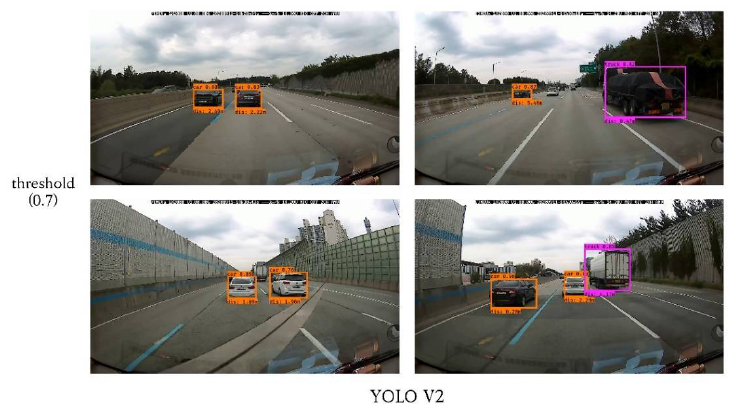
Figure 9. Learning Result of distance estimation.